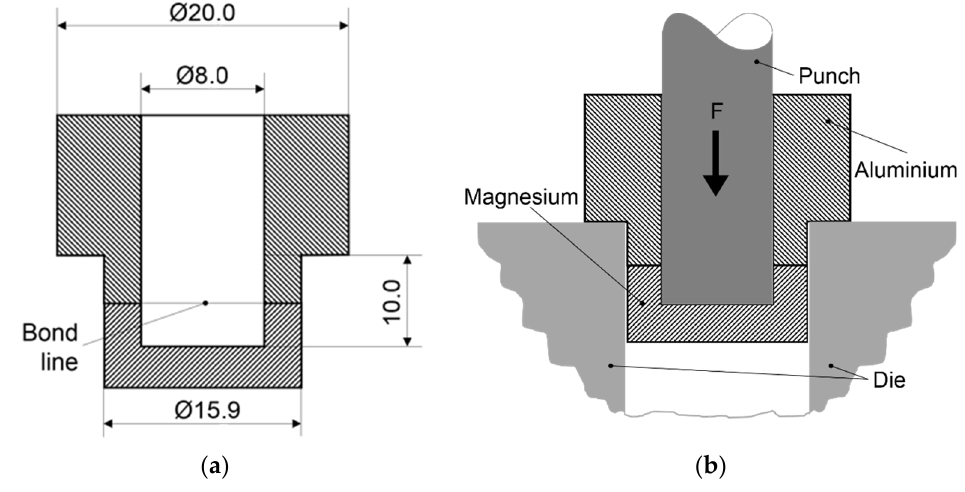
Figure 2. Tensile testing of diffusion bonded joints ( a ) characteristic geometrical dimensions of a top hat sample and ( b ) schematic testing setup.